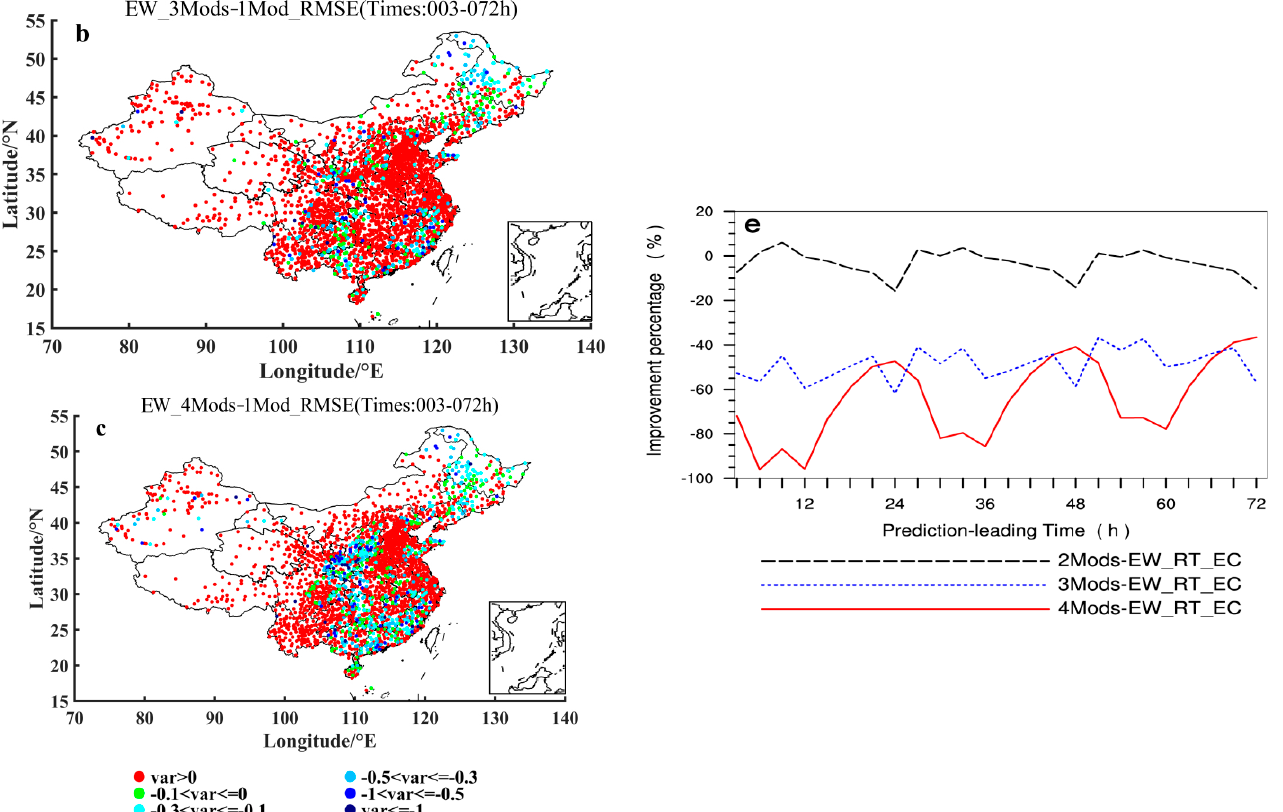
Figure 8. Distributions of the 2 m temperature prediction RMSEs differences (units: ◦ C) between ( a ) 2 and 1, ( b ) 3 and 1, and ( c ) 4 and 1 models ensemble forecasting using the EW ensemble method. ( d ) Variations of the percentage of the stations, where negative (see the text for further details) 2 m temperature prediction RMSEs differences (units: ◦ C) between 2 and 1 (2Mods-1Mod), 3 and 1 (3Mods-1Mod), and 4 and 1 (4Mods-1Mod) models ensemble forecasting using the EW ensemble method are shown, with respect to the prediction leading times. ( e ) Variation of improvement percentage of the 2-, 3- and 4-models ensemble forecasting using the EW method relative to the ECMWF forecasting, with respect to the leading times. The specific models taken for the 2-, 3- and 4-models ensemble forecasting are shown in Table 1, and the 1 model indicates the ECMWF